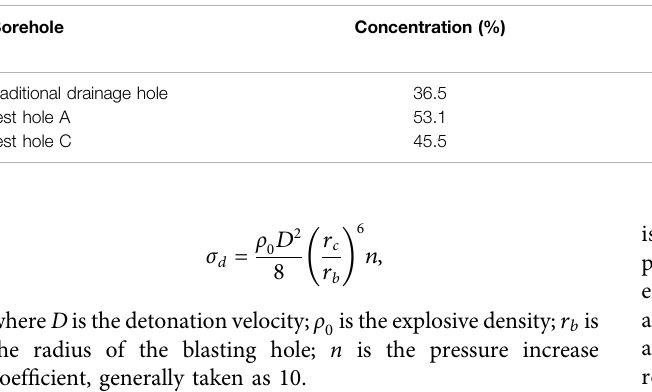
TABLE 3 | Drainage data of blasting permeability enhancement hole and traditional